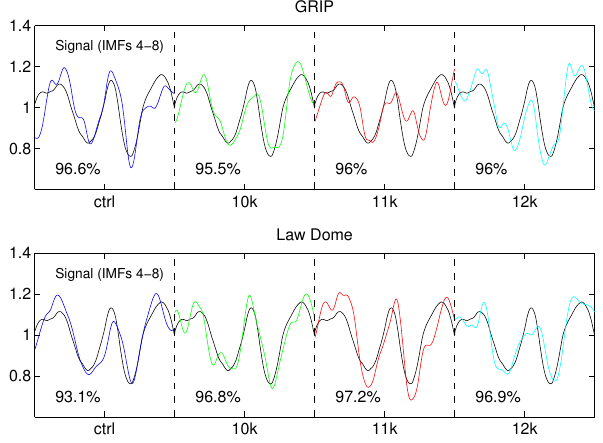
Fig. 8. The seven intrinsic mode functions (IMF1-7) and the long-term trend (IMF8) of 10 Be deposition (atoms/m 2 /s) at the Law Dome station.